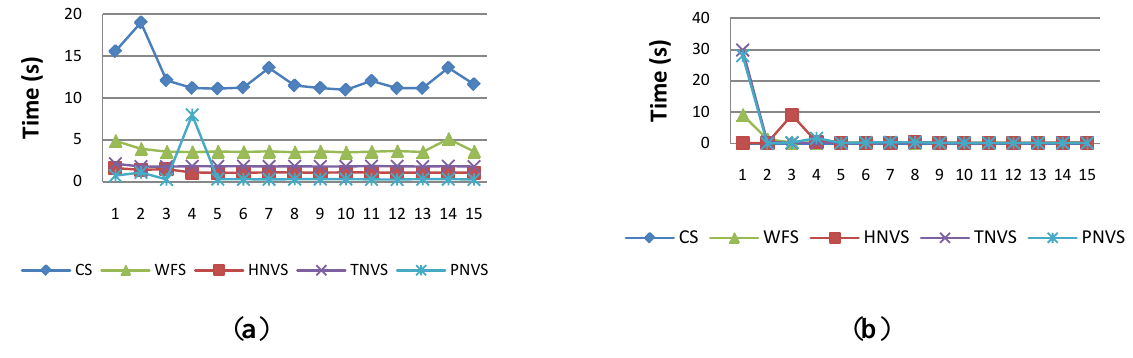
Figure 8. Execution times of the composite services in ( a ) RRM and ( b )